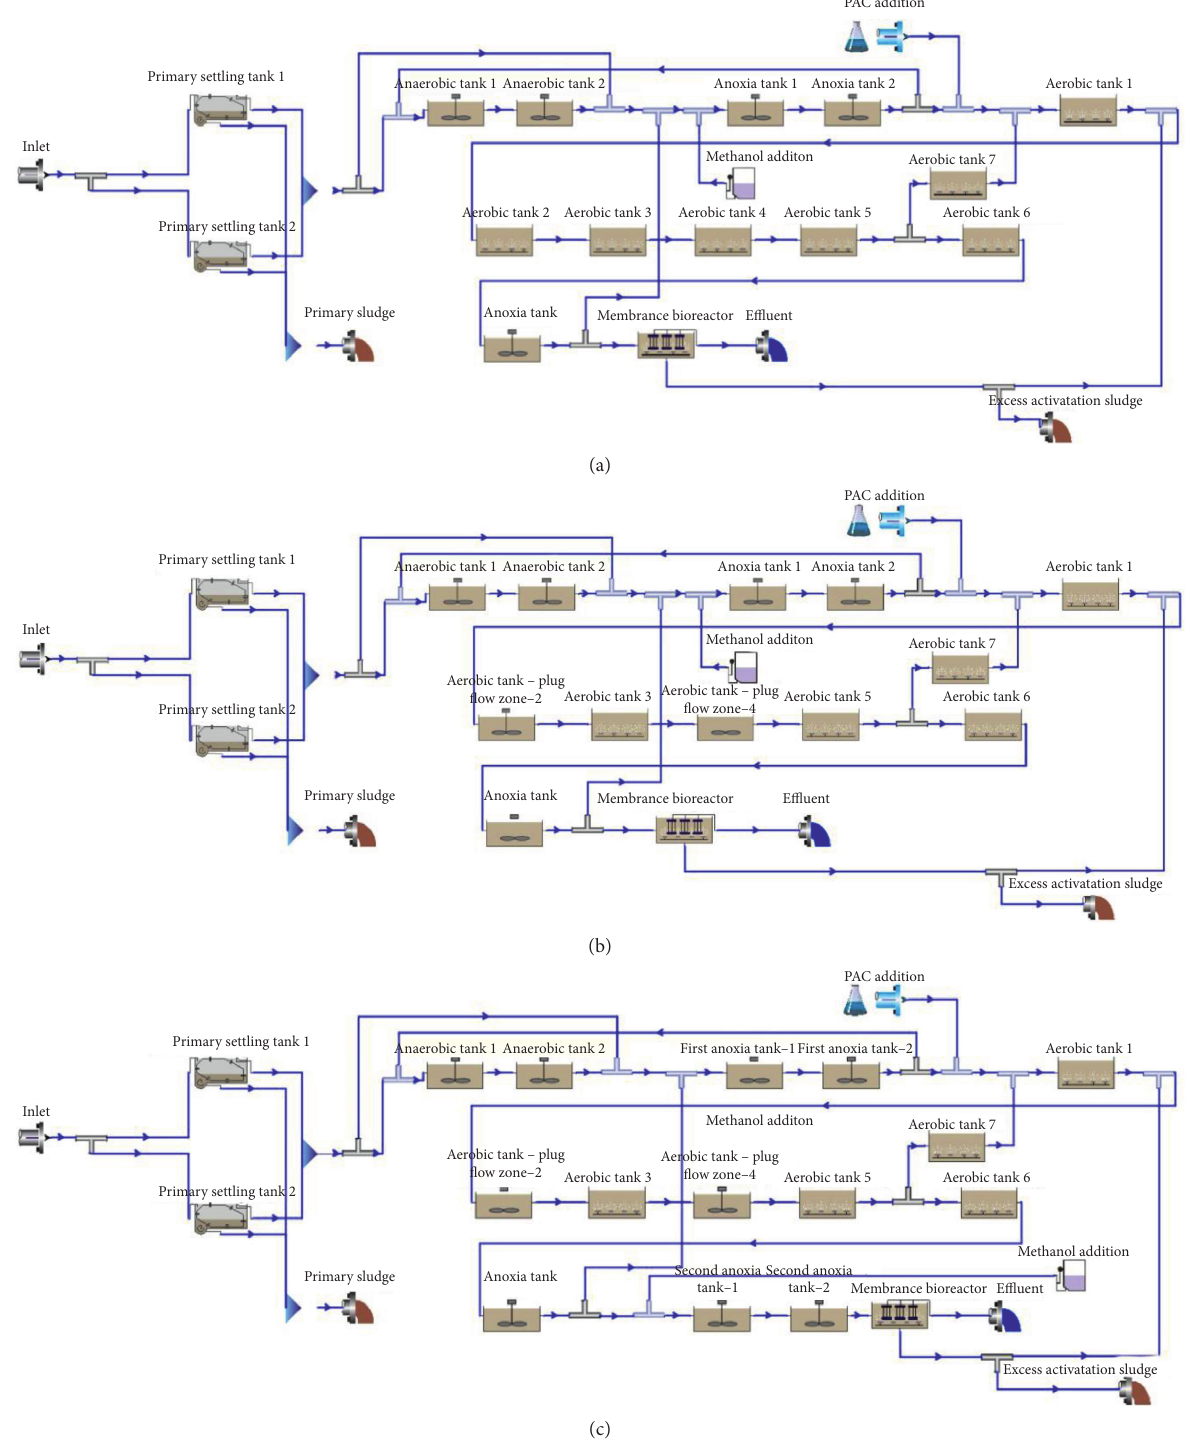
Figure 3: Simulated process flows: (a) Solution 1; (b) Solution 2; (c) Solution